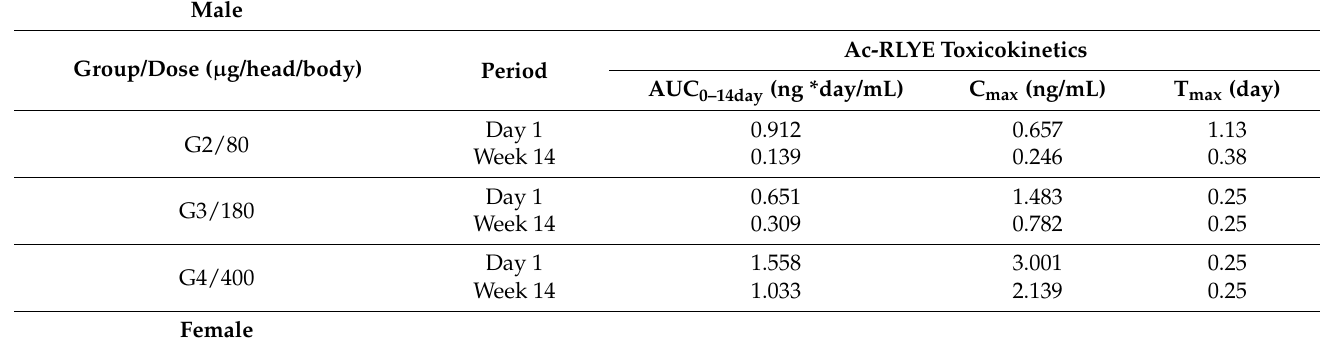
Table 2. Toxicokinetic parameters of Ac-RLYE following repeated intravitreal administration in rabbit. Male Group/Dose ( µ